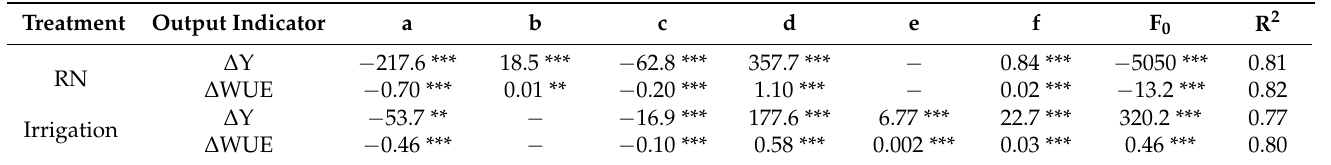
Table 7. The coefficients of the regression analysis (a, b, c, d, e, f, F 0 ) for assessing the impact of climate change on wheat yield and WUE under rain-fed (RN) and irrigation. ∆ Y/ ∆ WUE = a ∆ T